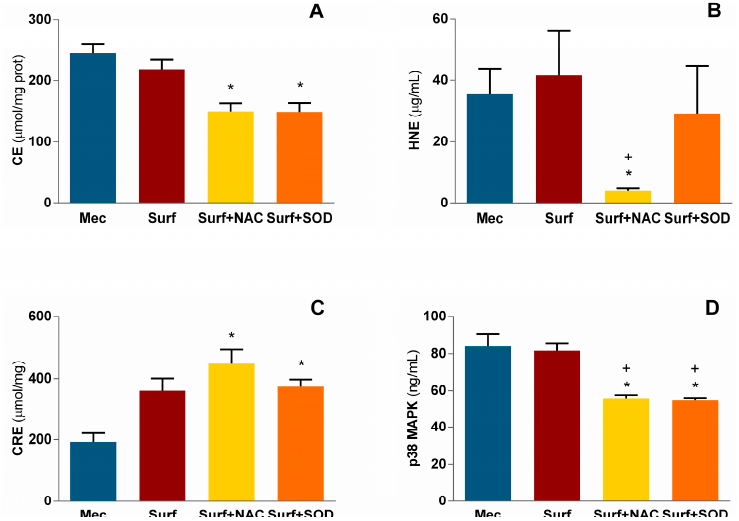
Figure 2. Levels of ( A ) advanced oxidation protein products, ( B ) hydroxynonenal (HNE), ( C )